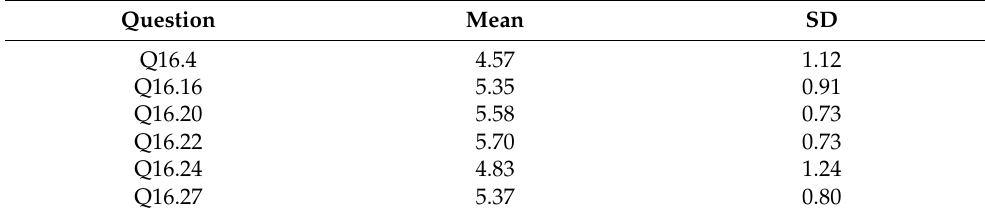
Table 5. Mean values and standard deviation for the “Caring” questions.